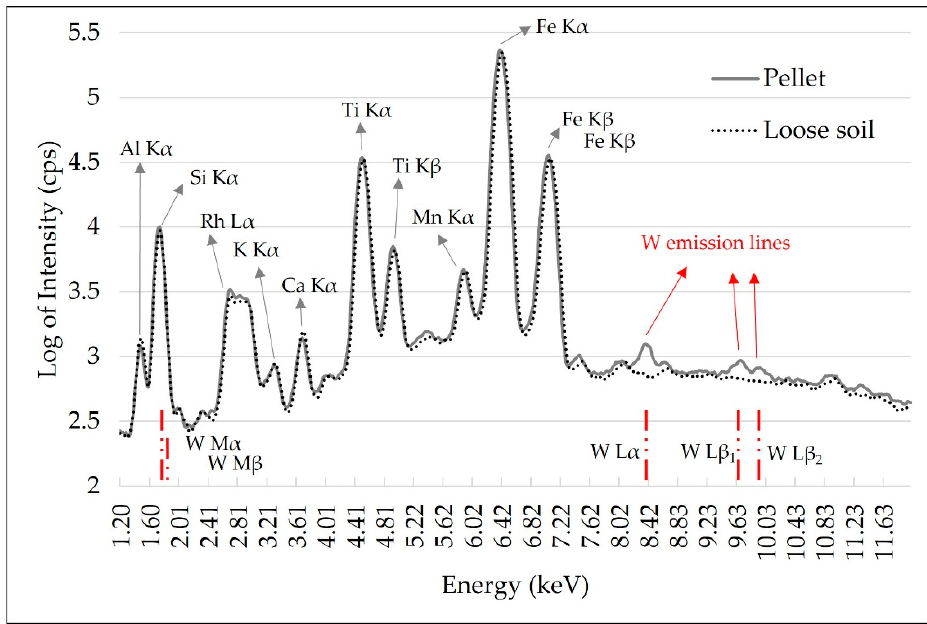
Figure 3. X-ray fluorescence spectra obtained with pXRF equipment using the pellet and loose soil sample. Tungsten (W) emission lines were identified with red lines. The emission spectra intensity is shown in the logarithm to reduce the differences in scales between the emission lines, allowing a better qualitative assessment.